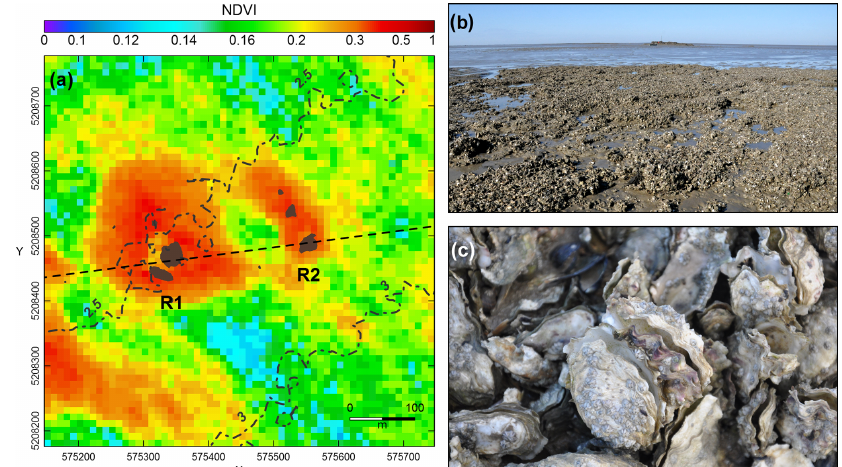
Figure 2. (a) NDVI map of the experimental site (SPOT 5 image acquired on 8 September 2009). The sector is 600 × 600m, limited by a channel on the left. The control reef (R1) and the impacted reef (R2), both formed of several emerging parts, are represented in brown. The grey dotted lines correspond to the bathymetric levels. The black dashed line represents the transect used in the analysis of the biomass variations between R1 and R2. (b) View of the reef where the oysters were burnt (R2); R1 is visible in the background. (c) Open shells of dead oysters after the burning (photographs acquired in September